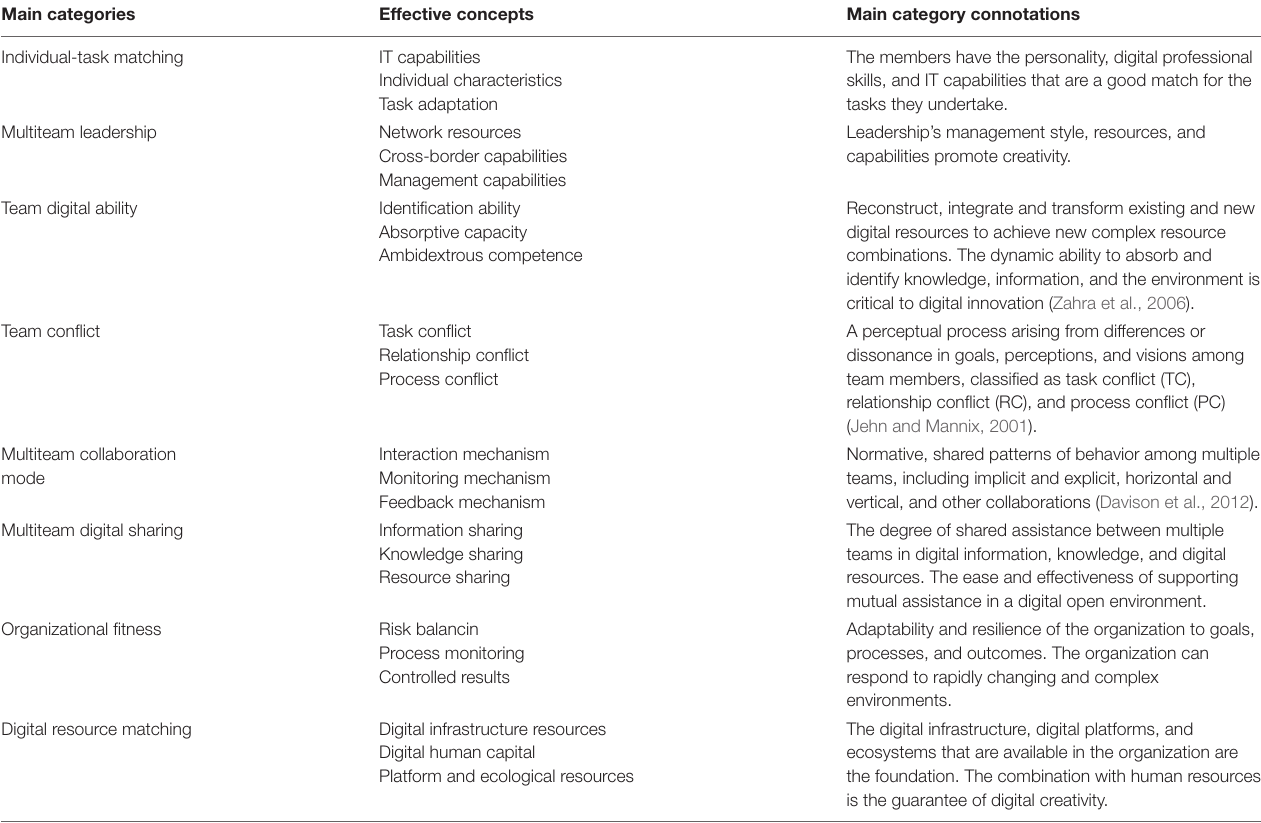
TABLE 2 | Main category library of the second-level coding in the action